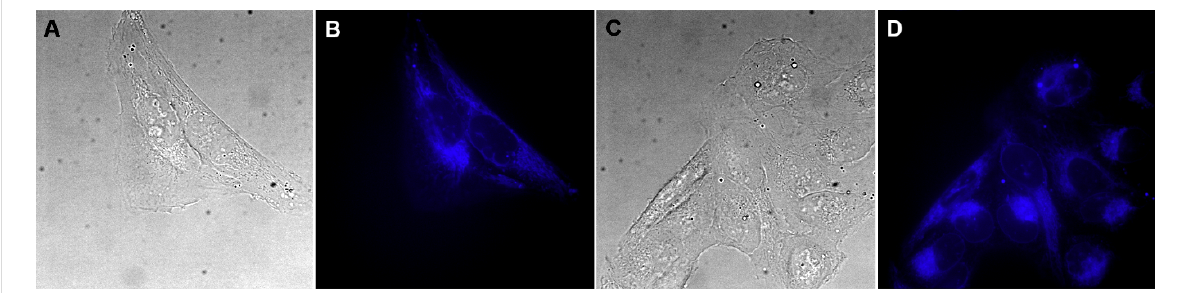
Figure 2: Intracellular localization of archangelolide-dansyl ( 5 ) in human cells from osteosarcoma (U-2 OS). A, C) Bright-field images; B, D) fluorescence microscopy of living cells treated with 1 µM concentration of compound 5 for 90 min.